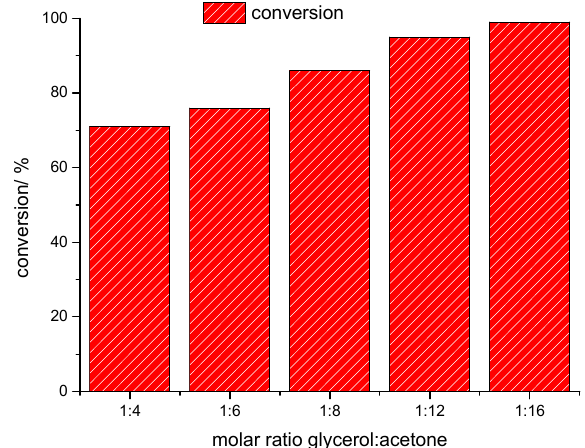
Figure 27. The impacts of variation on the stoichiometry of reactants on Sn 2 SiW 12 O 40 -catalyzed glycerol condensation with acetone (adapted from ref. [72]). Reaction conditions: glycerol: acetone (variable); volume (10 mL); catalyst (0.01 mol%); 298 K.